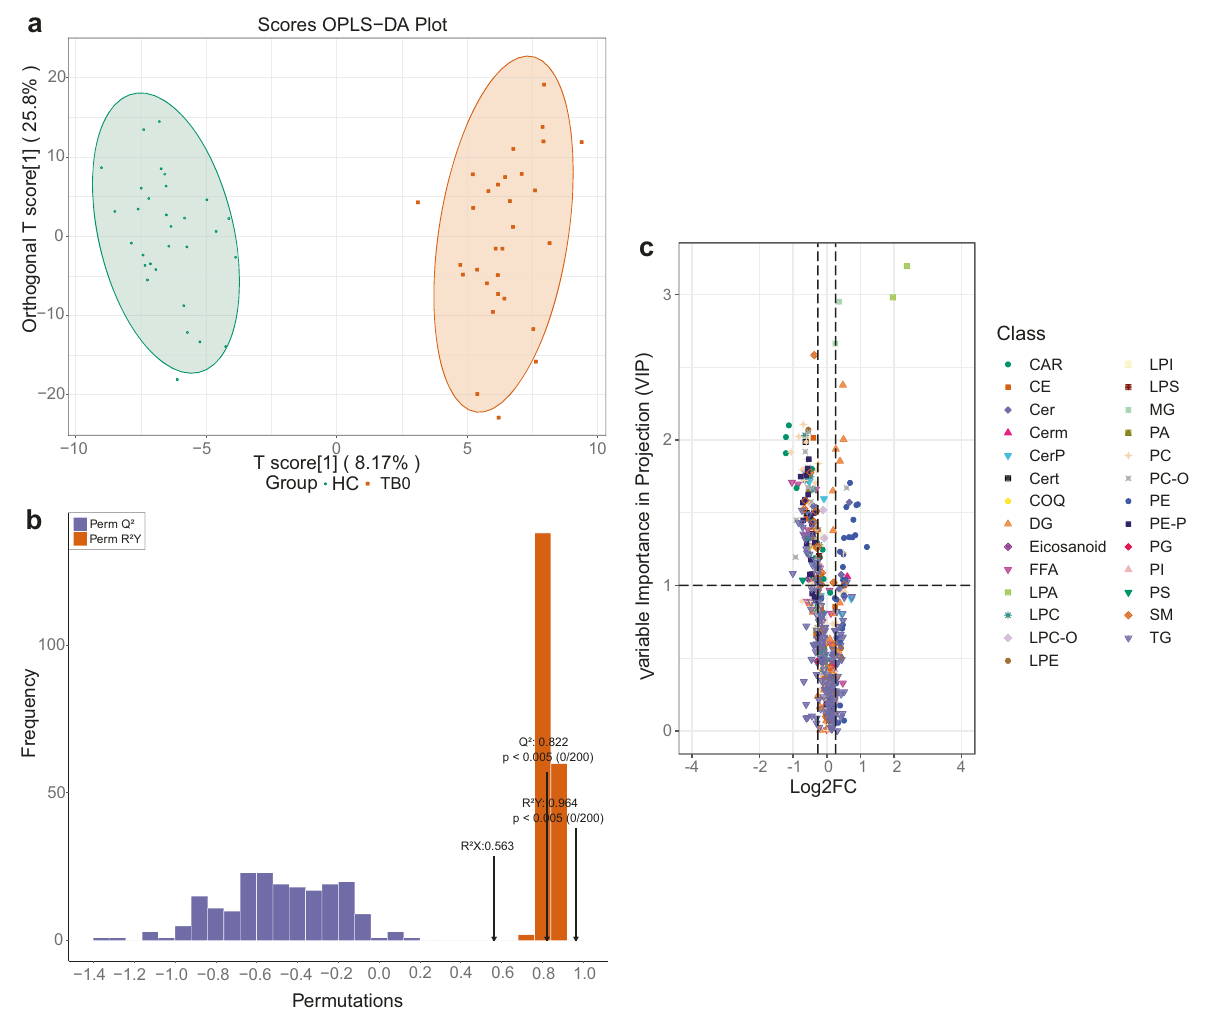
Fig. 1 Establishment and validation of OPLS-DA model (TB0 group vs. HC group), and screening of differential lipids. a The OPLS-DA model was able to separate the TB0 group from HC group clearly based on the selected lipid metabolites. b The model had good prediction ability, permutation test showed that R2X (cum) = 0.563, R2Y(cum) = 0.964, Q2(cum) = 0.822. c The differential lipids between the two groups were identi fi ed by volcanic map. The abscissa showed the different fold changes (logFC) of each lipid substance in different groups, the ordinate showed VIP value, and the different scatter colors and shapes represented the screening results of different lipid